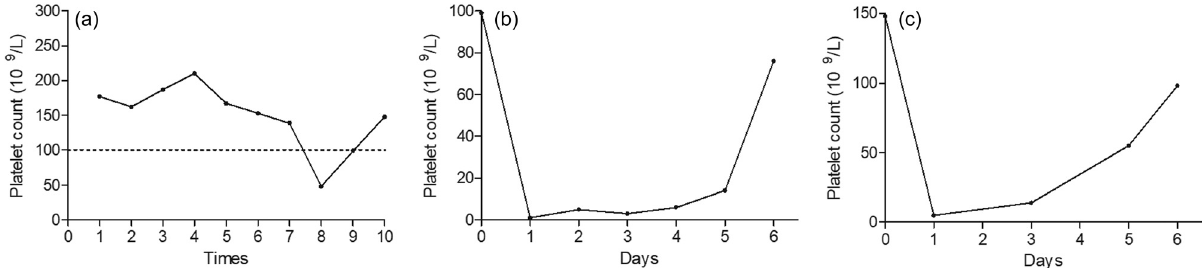
Figure 1: Platelet count changes during trastuzumab therapy: ( a ) before each trastuzumab infusion; ( b ) during the 10th infusion of trastuzumab; and ( c ) during the 11th infusion of